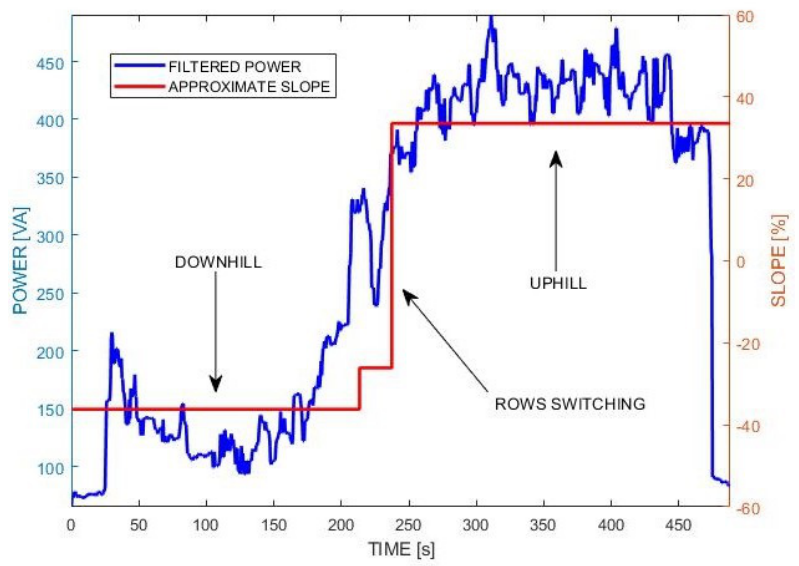
Figure 15. Filtered consumed power (blue) over time with average slope angle (red) during work in the Zelina steep slope vineyard. A segment of the vineyard navigation is zoomed in.